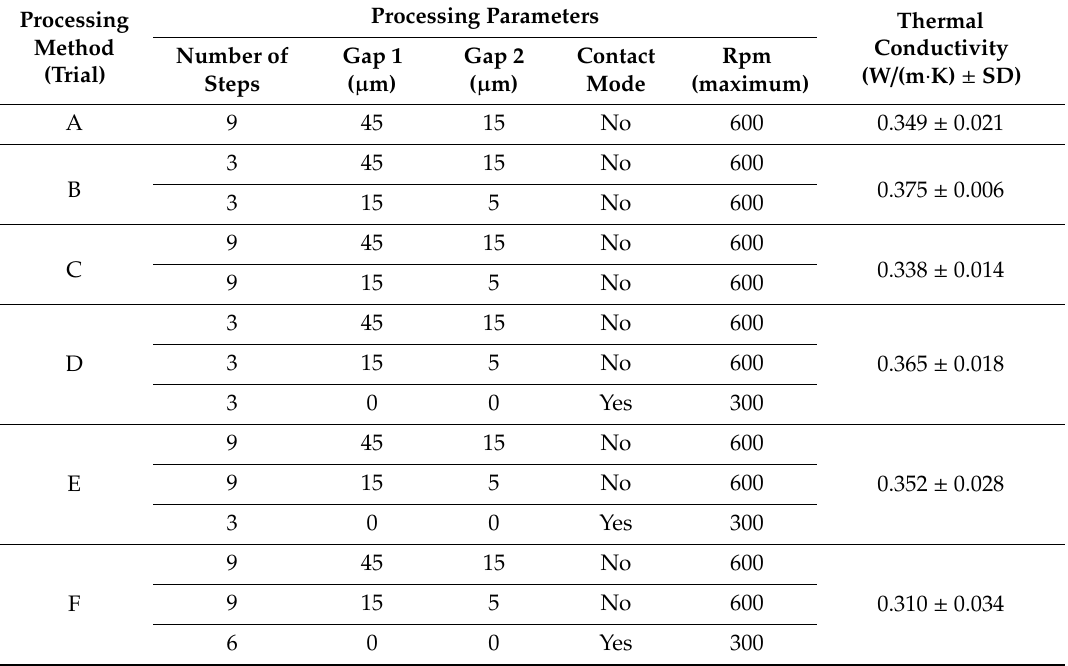
Table 1. Three roll mill trials for epoxy graphene-like nanoplatelets (GNPs) (2 wt.%)